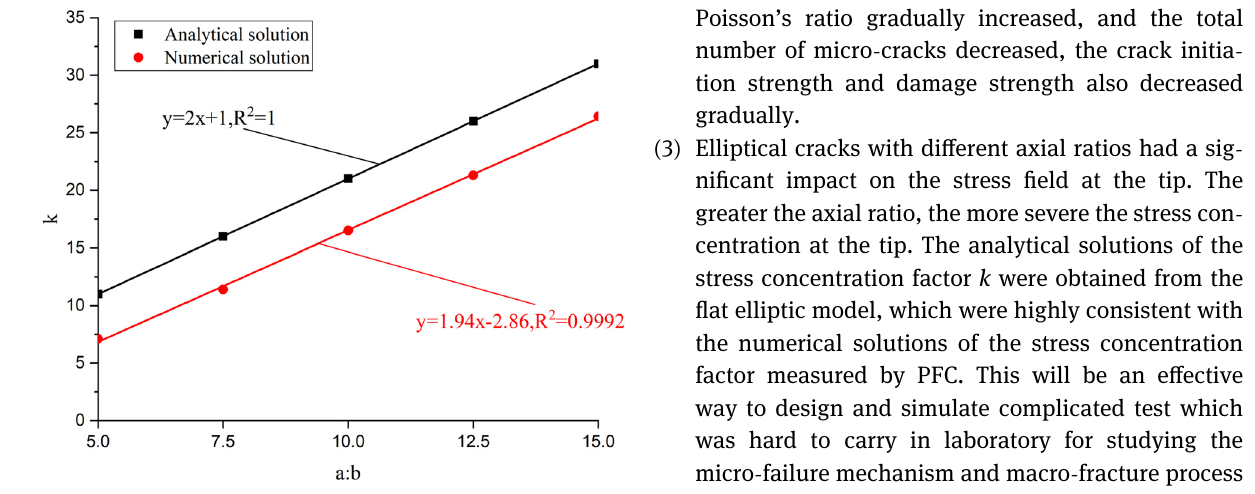
Figure 8: The k - value of analytical solutions and numerical